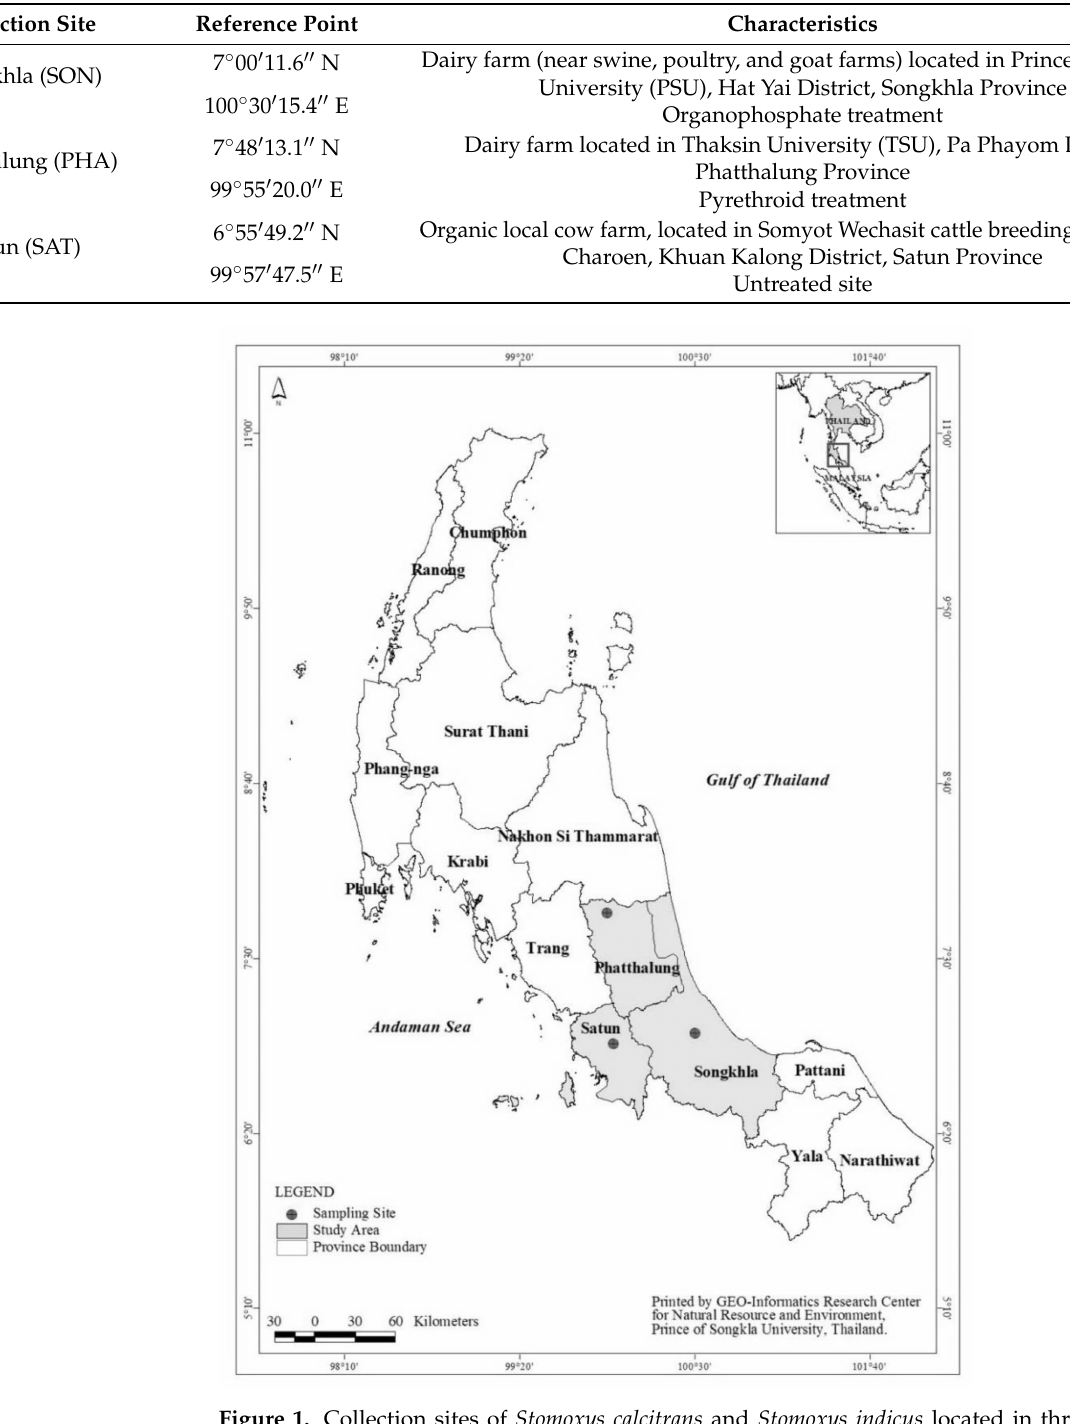
Figure 1. Collection sites of Stomoxys calcitrans and Stomoxys indicus located in three provinces: Phatthalung, Satun, and Songkhla, Southern